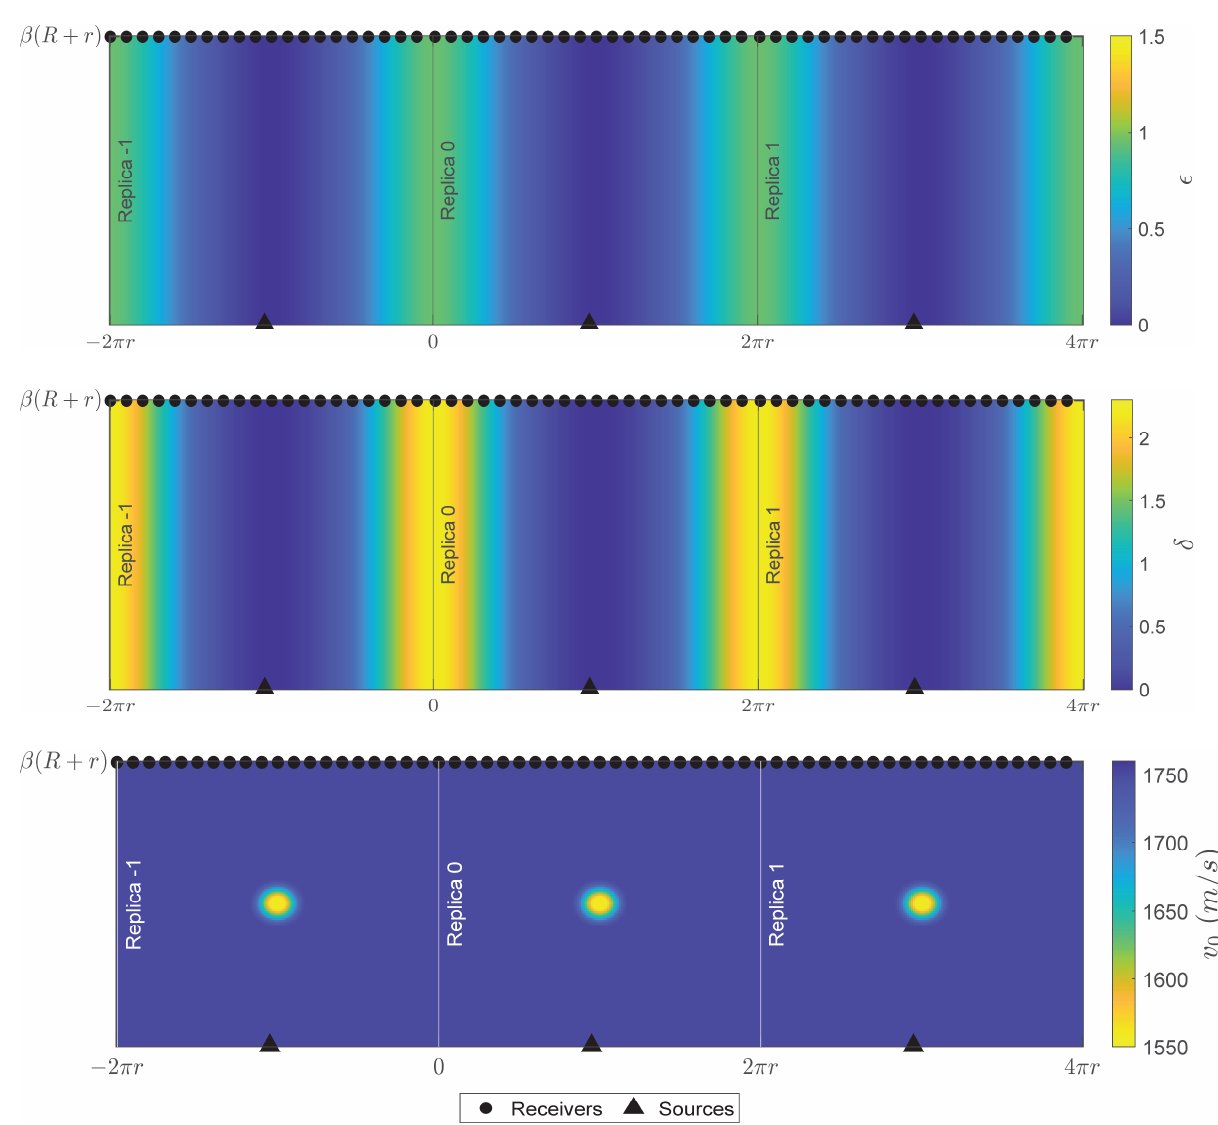
Figure 7. ( a , b ) (cid:101) and δ distribution along the bend with 3 replicas, respectively. Sources were placed at the extrados position of each replica. ( c ) v 0 in the bend with a Hann-shaped defect located at the extrados position. A similar velocity model was created for each computed